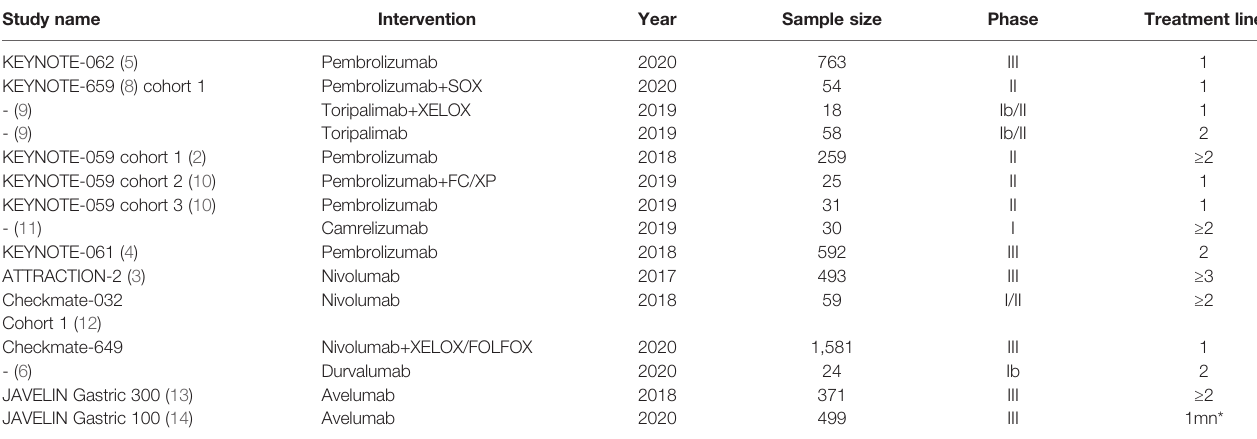
TABLE 1 | Basic characteristics of included studies.